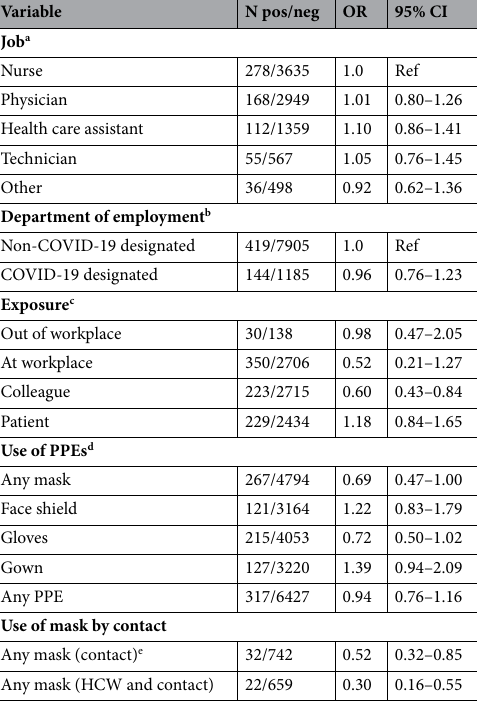
Table 5. Odds ratio of SARS-CoV-2 infection in HCWs according to source of contact and use of PPEs. OR odds ratio, CI confidence interval, Ref reference category. a OR adjusted for sex, age, and center. b OR adjusted for sex, age, center, and job title. c Self-reported source of contact at least one contact; OR adjusted for sex, age, center and other sources of contacts. d Self-reported PPE at least one contact; OR adjusted for sex, age, center, job title and other PPEs. e Self-reported at least one contact; OR adjusted for sex, age, center and use of mask by